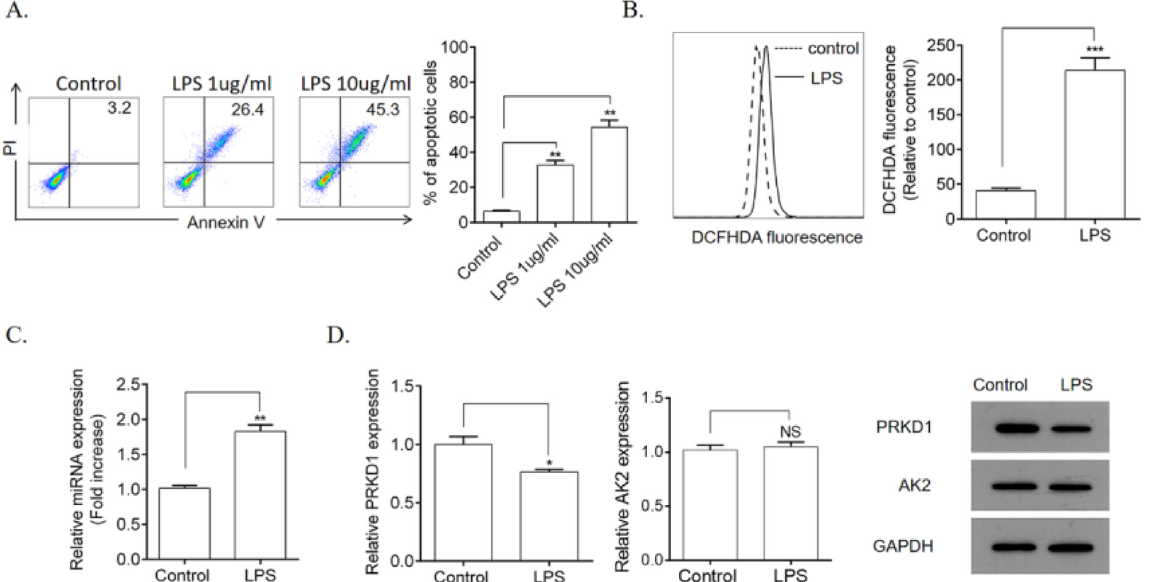
Figure 1. Detection of Human Pulmonary Microvascular Endothelial Cell (HPMEC) apoptosis via FCM analysis. HPMECs were treated with Lipopolysaccharide (LPS) (1 and 10 μ g/mL) for 24 h. Apoptosis was detected via FCM analysis. Apoptotic cells were expressed as annexin V- and PI-positive cells. (A) Reactive Oxygen Species (ROS) production was measured using 2.7-Dichloro fl uorescein Diacetate (DCFHDA) (10 µ M) via FCM analysis ( n = 4). (C, D) Expression levels of miRNA, PRKD1, and AK2 were detected using real-time quantitative Polymerase Chain Reaction (qRT-PCR) and western blotting. HPMECs were evaluated after treatment with LPS (1 μ g/ mL) or PBS for 24 h. Gene and protein expression levels were normalized to those of the control group ( n = 4). Data are represented as mean ± SEM. * p < 0.05, ** p < 0.01, *** p <